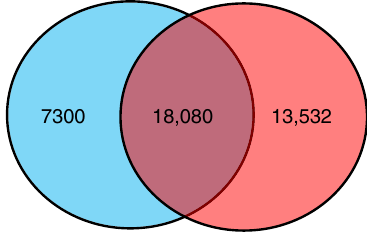
Fig. 2 Venn diagram showing the distribution of OTUs across the bio fi lms in the current study (blue) and the Tara miTags (red) comprising 16S rRNA sequences from 243 seawater samples